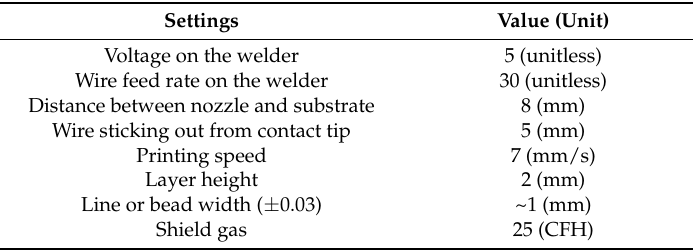
Table 1. Settings for open-source GMAW-based steel 3-D